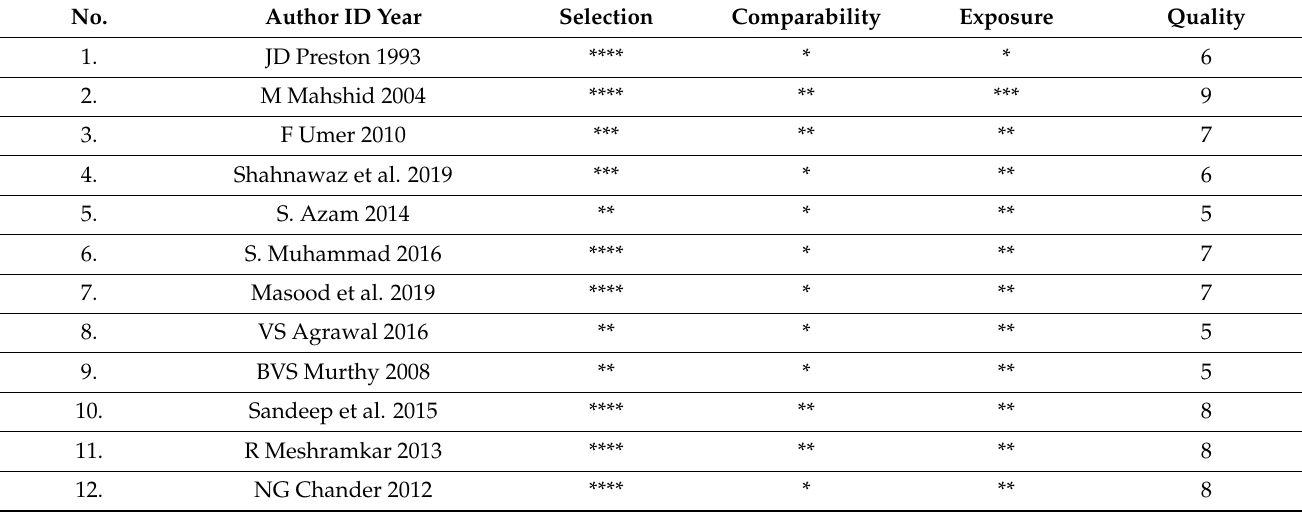
Table 6. Newcastle-Ottawa scale for quality assessment of included articles ( n =